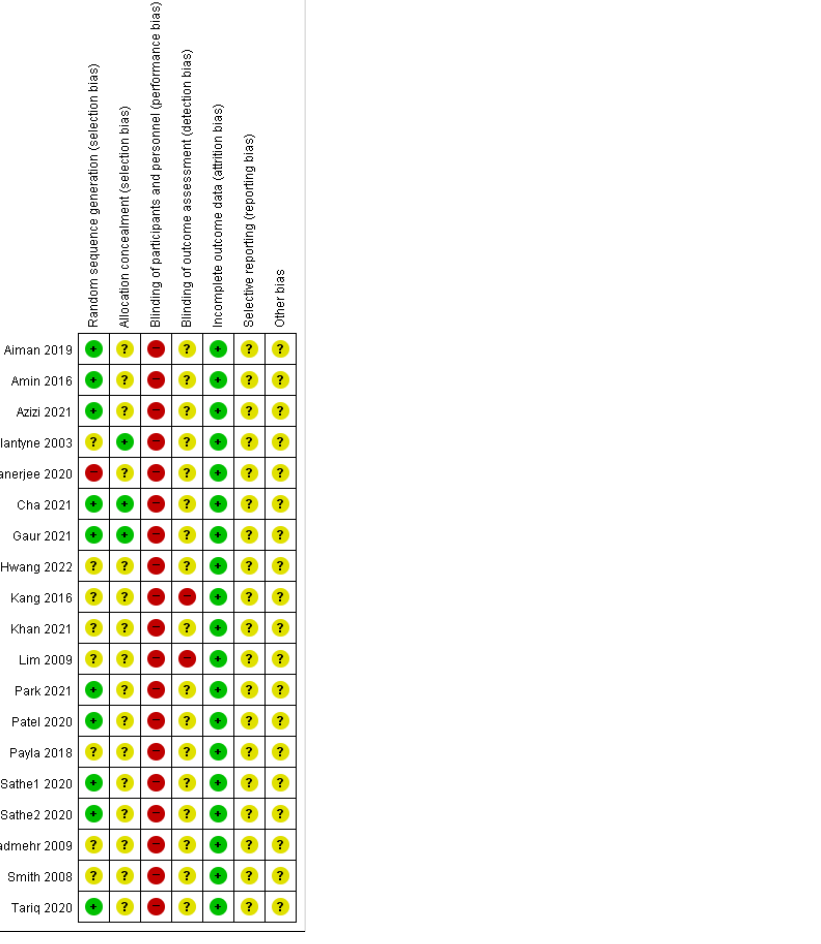
Figure 7. Risk of bias summary [10,15,17,33–48]. (+) = low risk of bias; (?) = unclear risk of bias; (−) = high risk of bias.